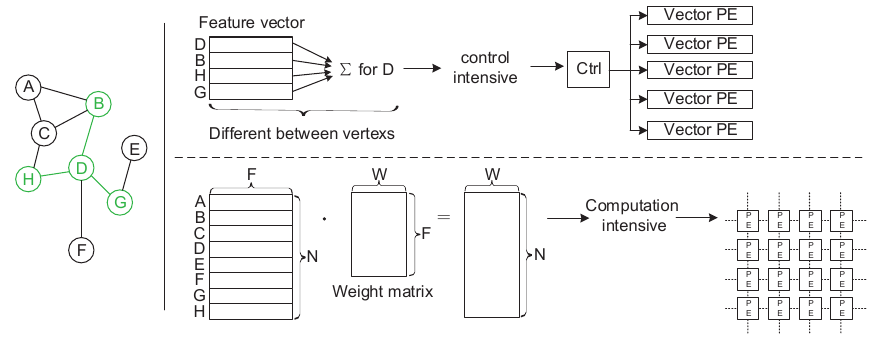
Figure 3. Control-intensive and computation-intensive in GCNs. Vertex D and its adjacent vertexes are marked in green.